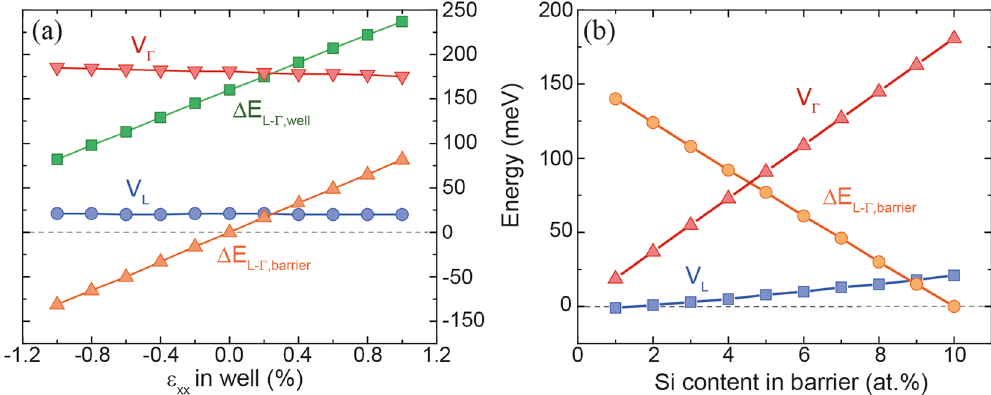
Figure 5. Influence of strain ( a ) and Si content in SiGeSn ( b ) on band alignment parameters for a Ge 0.84 Sn 0.16 / Si 0.10 Ge 0.75 Sn 0.15